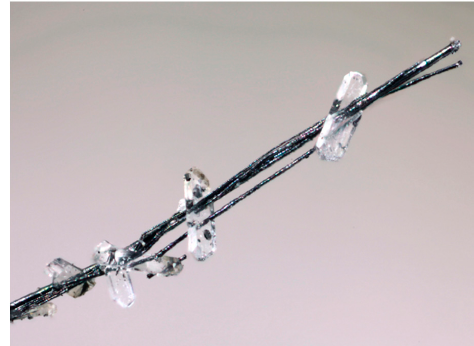
Figure 3. Optical photograph of whiskers of merelaniite to 2.8 mm long associated with crystals of stilbite and graphite (sample 3665c), found in a small crevice on an 11-cm long alabandite crystal (private collection).